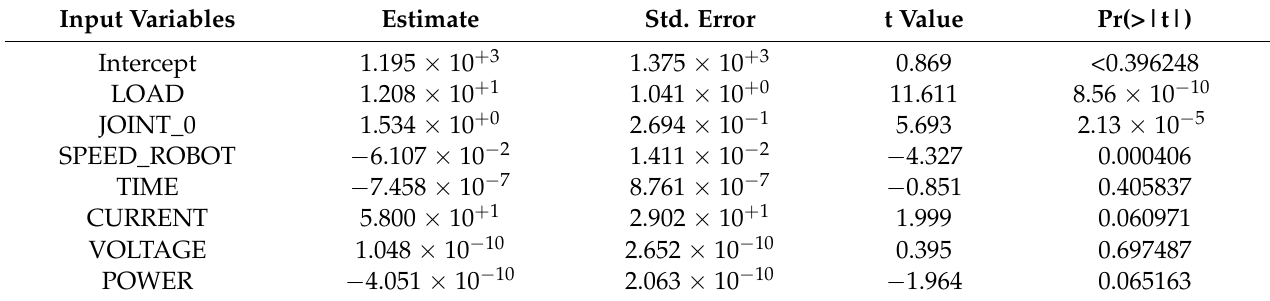
Table 5. Performances of the linear regression model when predicting the robot